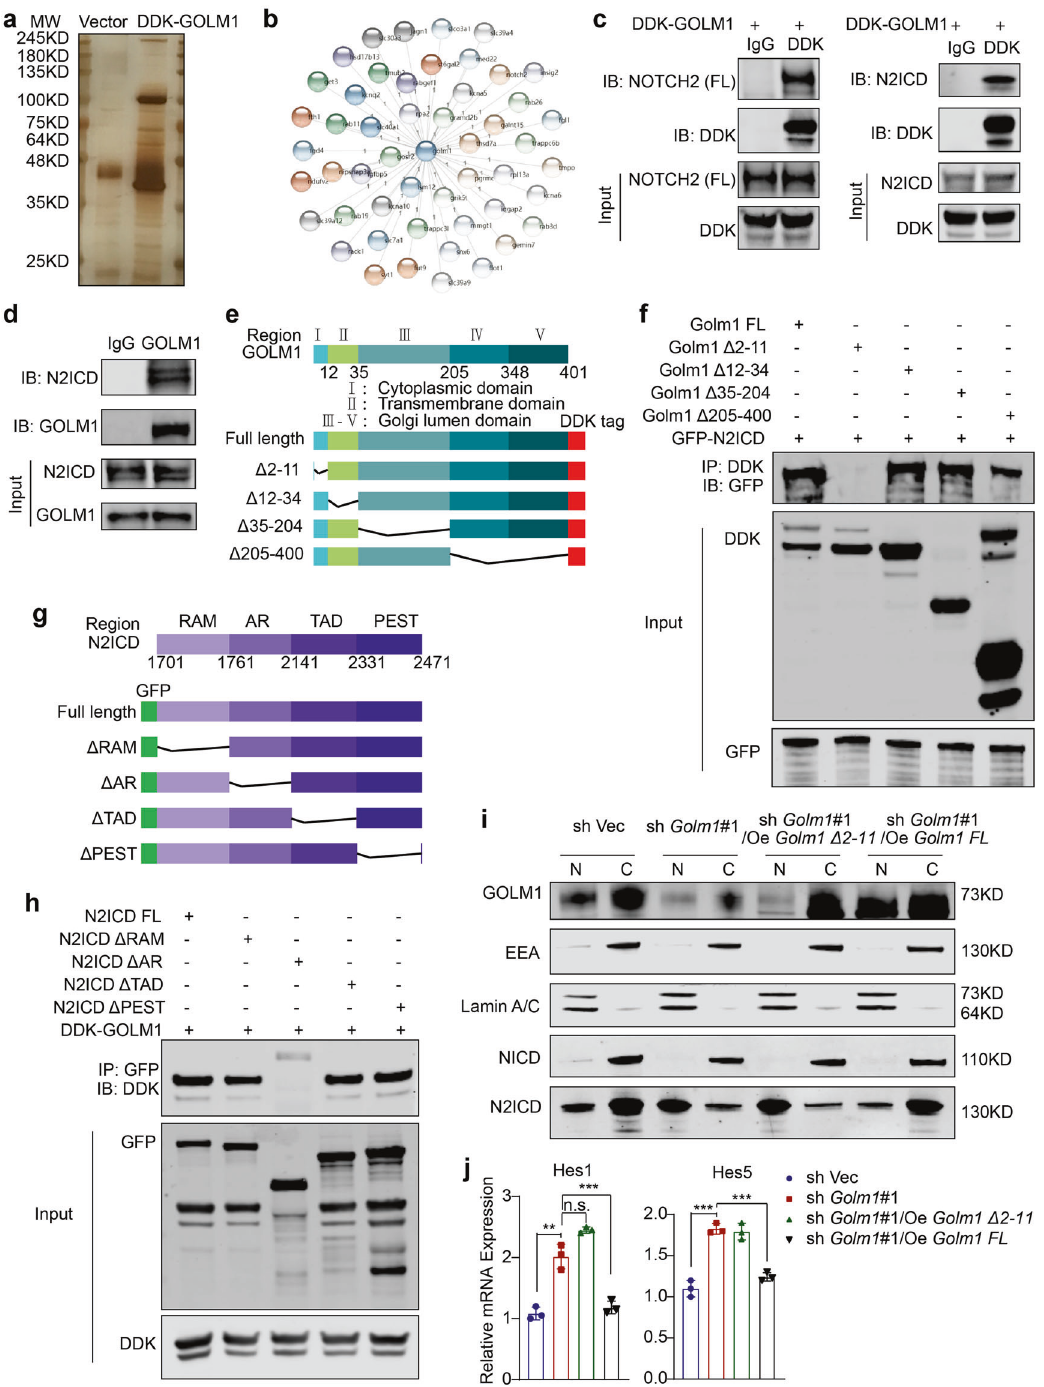
both the entire crypt and the surface epithelial cells (damage score